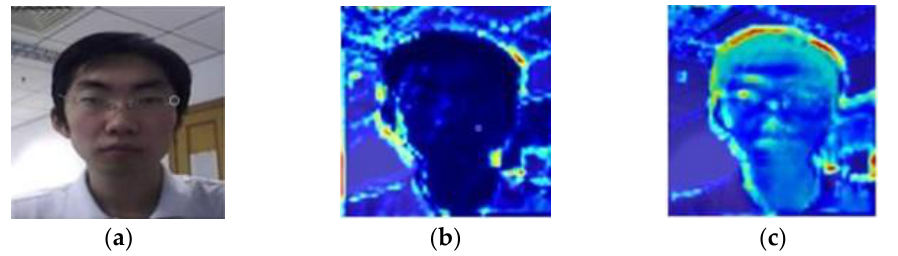
Figure 12. Visualized results. ( a ) Original. ( b ) ResNet50. ( c ) SE-ResNet50.